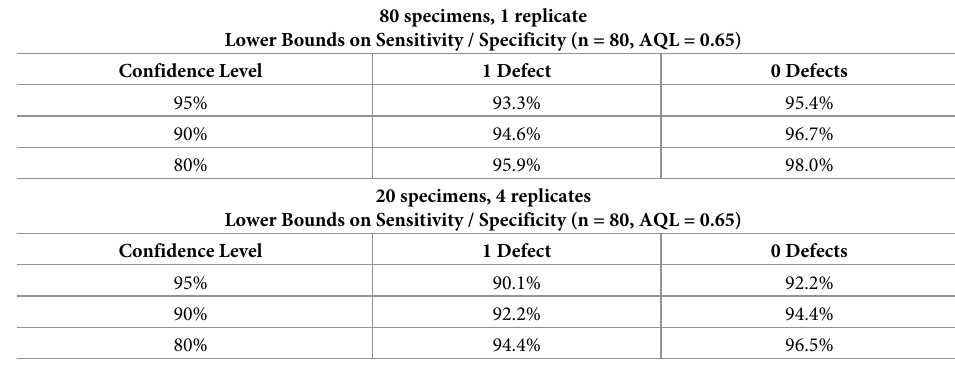
Table 1. Lower bounds on specificity and sensitivity, estimated through the Wilson scores approach [28–30], for the respective number of defects and confidence levels for testing scenarios involving either 80 specimens (with 1 replicate each) or 20 specimens (with 4 replicates